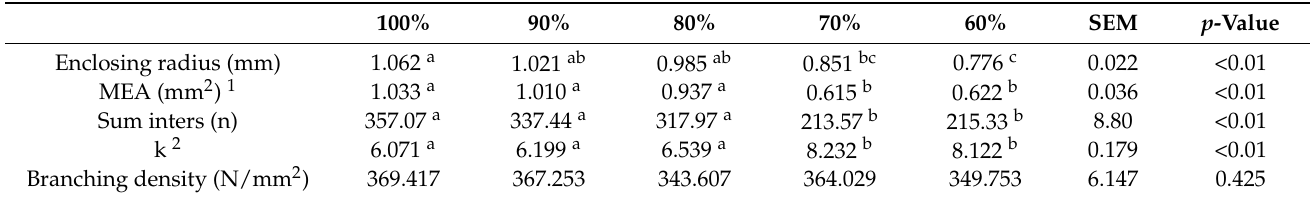
Figure 3. Whole-mount and Sholl analysis of #4 inguinal mammary glands from maternally restricted offspring. ( A ) Whole-mount image of mammary glands in different nutrient-restricted groups. ( B ) Bubble plot of mammary gland Sholl analysis. ( C ) Linear Sholl plots of mammary glands. ( D ) Principal component analysis (PCA) biplot of mammary gland Sholl results. Table 2. Sholl analysis of mammary grands from maternally restricted offspring.